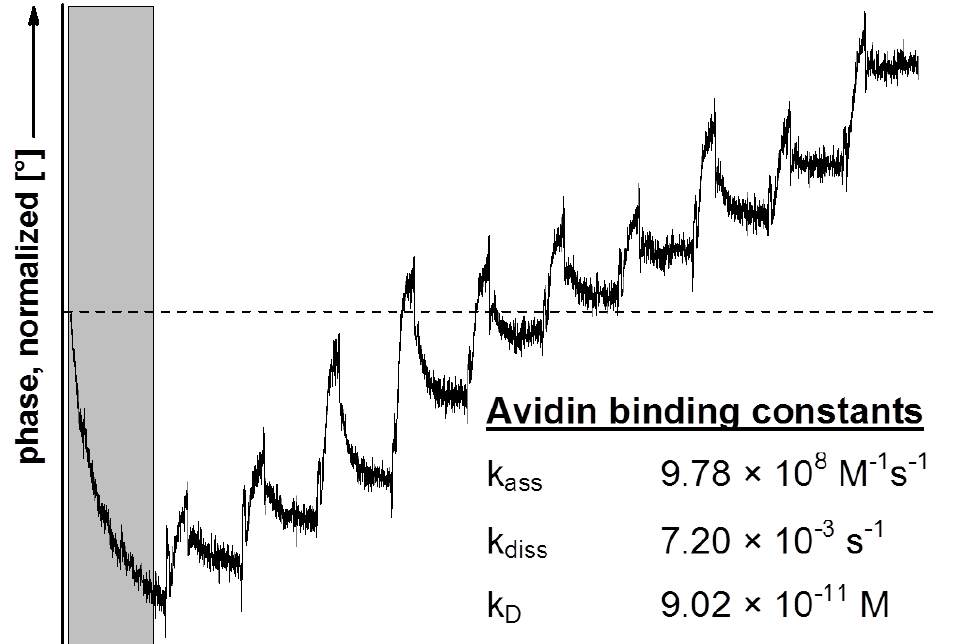
Figure 2. Illustration of avidin binding to POPC/biotinyl-PE covered and trehalose-protected SAW-quartz crystals. Trehalose replacement and rehydration immediately occurs after the run was started (deposited in grey). Avidin injections with increasing concentrations lead to an increase in the phase shifts. Kinetic binding constants, calculated from the SAW-sensorgram, are indicated and display an affinity in the sub-nanomolar